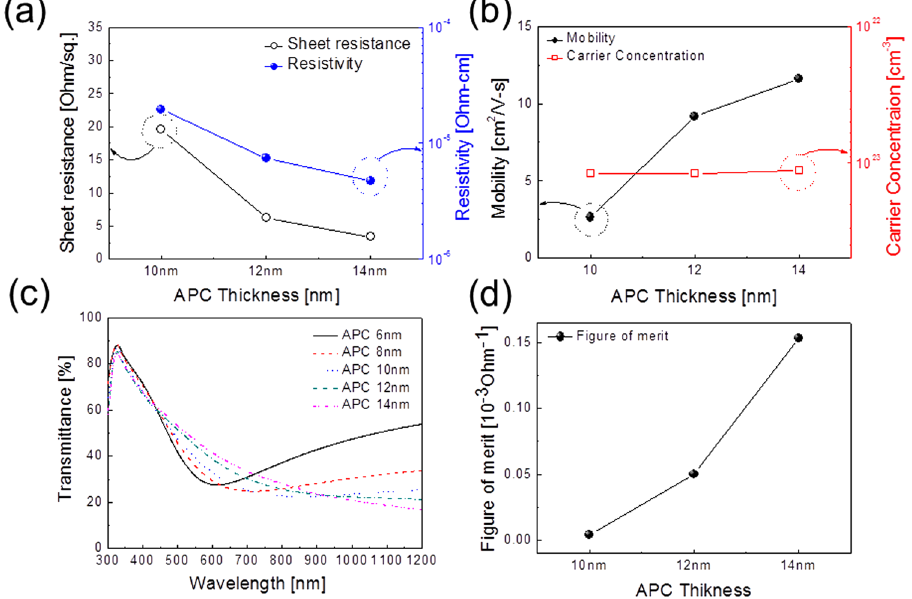
Figure 2. ( a ) Sheet resistance and resistivity and ( b ) mobility and carrier concentration of thermally evaporated APC layer on a PET substrate with increasing thickness from 6 to 14 nm. ( c ) Optical transmittance of the APC layer with increasing film thickness. ( d ) Figure of merit (FOM) values calculated from sheet resistance (R sh ) and optical transmittance (T) of the APC films.